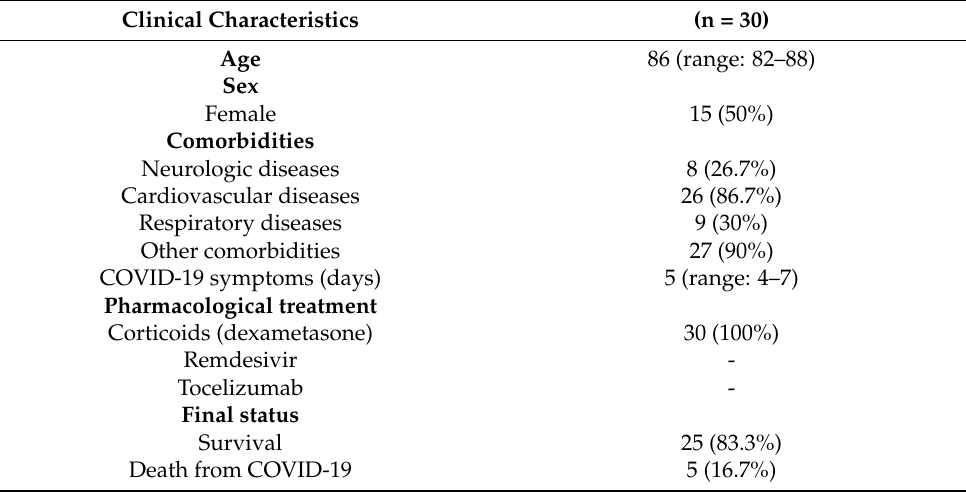
Table 1. Clinical variables of patients with COVID-19 treated with low-dose radiation